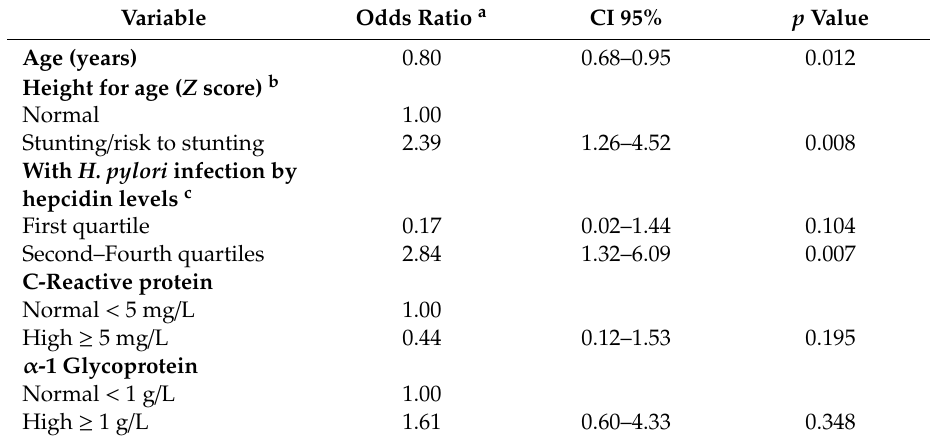
Table 4. Association between H. pylori infection and iron deficiency by hepcidin levels. Multivariate